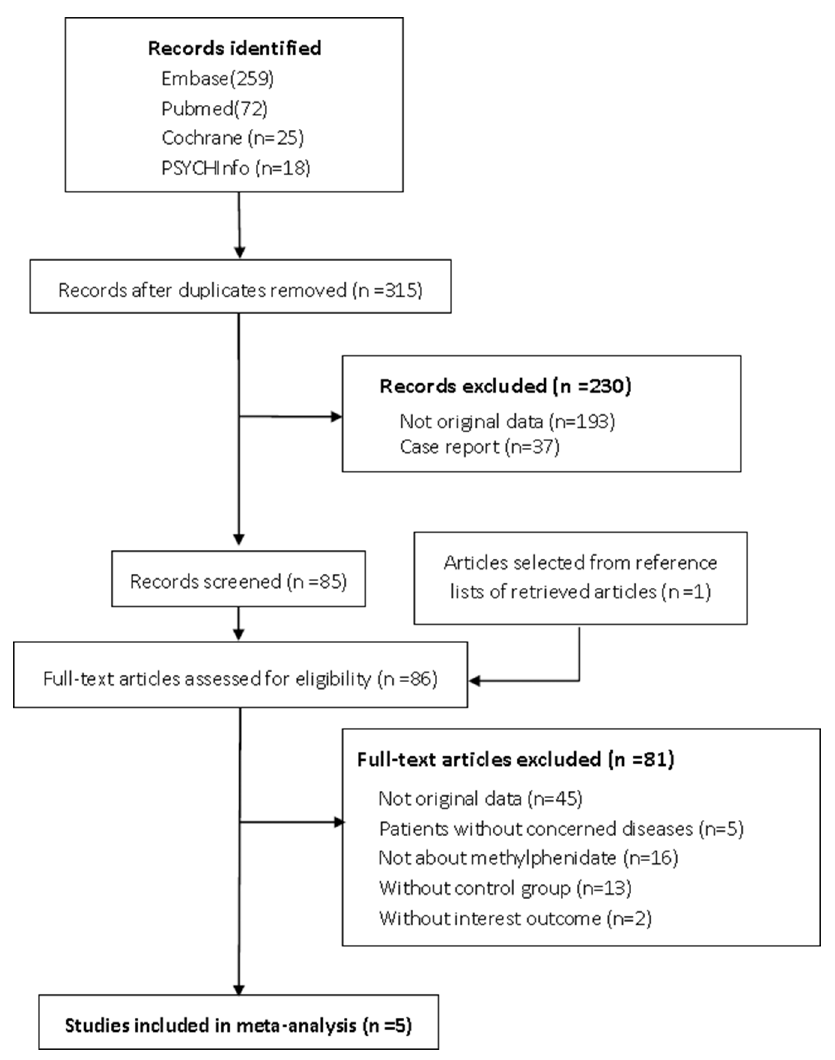
Figure 1. The flowchart shows the selection of studies for meta-analysis.